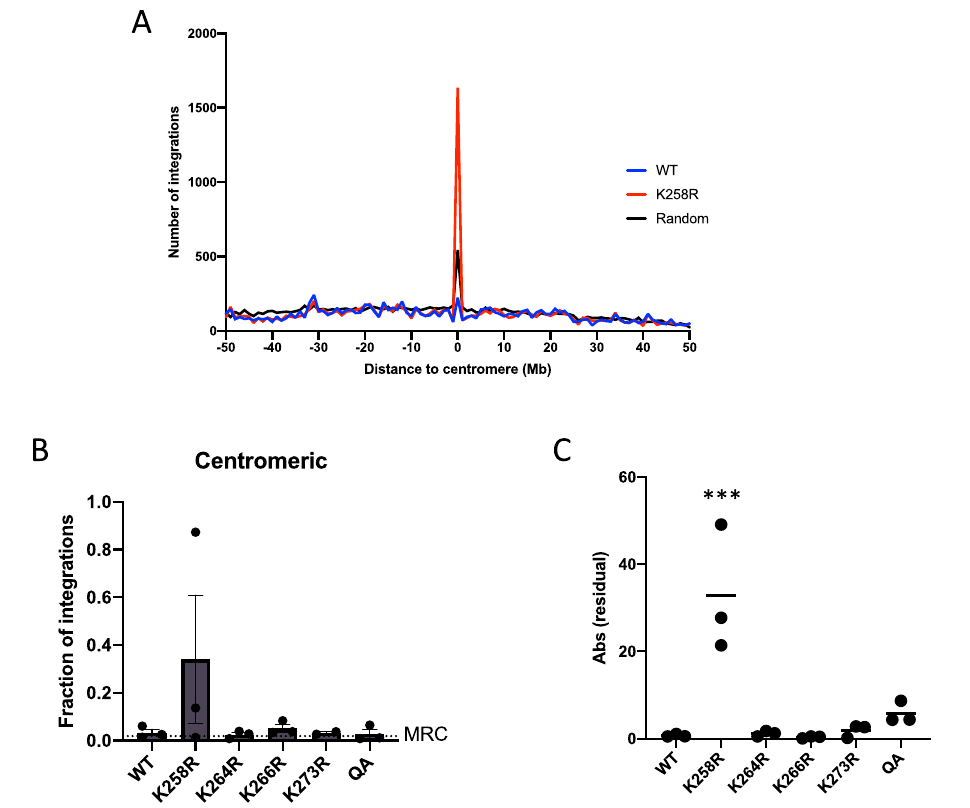
Fig. 3 K258R mutant HIV-1 IN profoundly biases integration toward centromeres. A The distance to the nearest centromere was calculated for all WT and K258R mutant integration sites from three independent experiments. A 50 Mb window fl anking each centromere was segmented into 100 equal sized bins of 1 Mb. The number of integrations falling in each bin was quanti fi ed and is shown as a count (WT in black, K258R in red). B Number of integrations located in centromeric regions were normalized to total detected integration sites and are shown as a percent of the total. Integration frequency into centromeres in the matched random control (MRC) data set is shown as a dashed line. Data is shown as the average of three independent biological replicates± SEs. Statistical signi fi cance relative to MRC was calculated by one-way ANOVA corrected for multiple comparisons. C To assess variability of the altered integration centromere targeting phenotype we plotted the absolute residual from the mean for each independent trial. Statistical signi fi cance of variance was calculated using Levene ’ s test (*** p < 0.0001, n = 3). Source data are provided as a Source Data fi